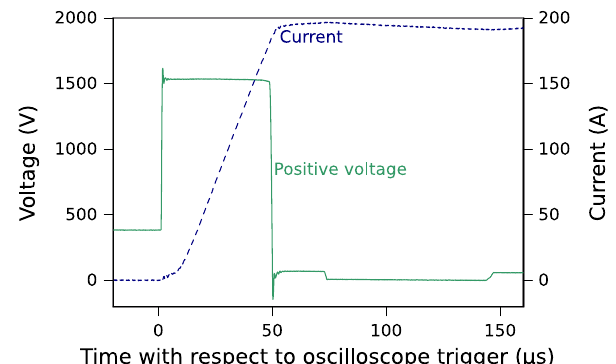
FIG. 14. Measured rising edge of current pulse to an operating current of 193 A, subsequent to installation at TRIUMF. Dashed blue trace: current. Solid green trace: positive-side output